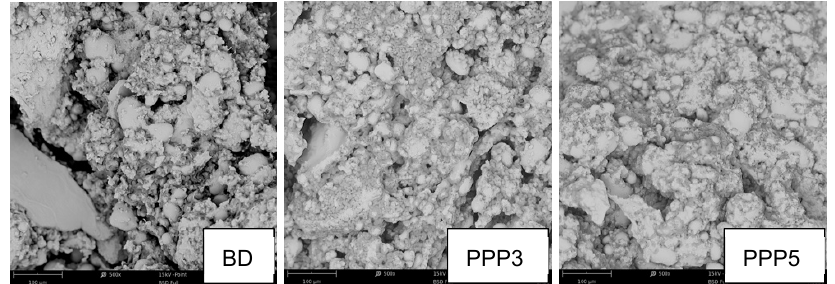
Figure 7. SEM images of the BD, P3, and P5 samples morphology. Magnification 500X.